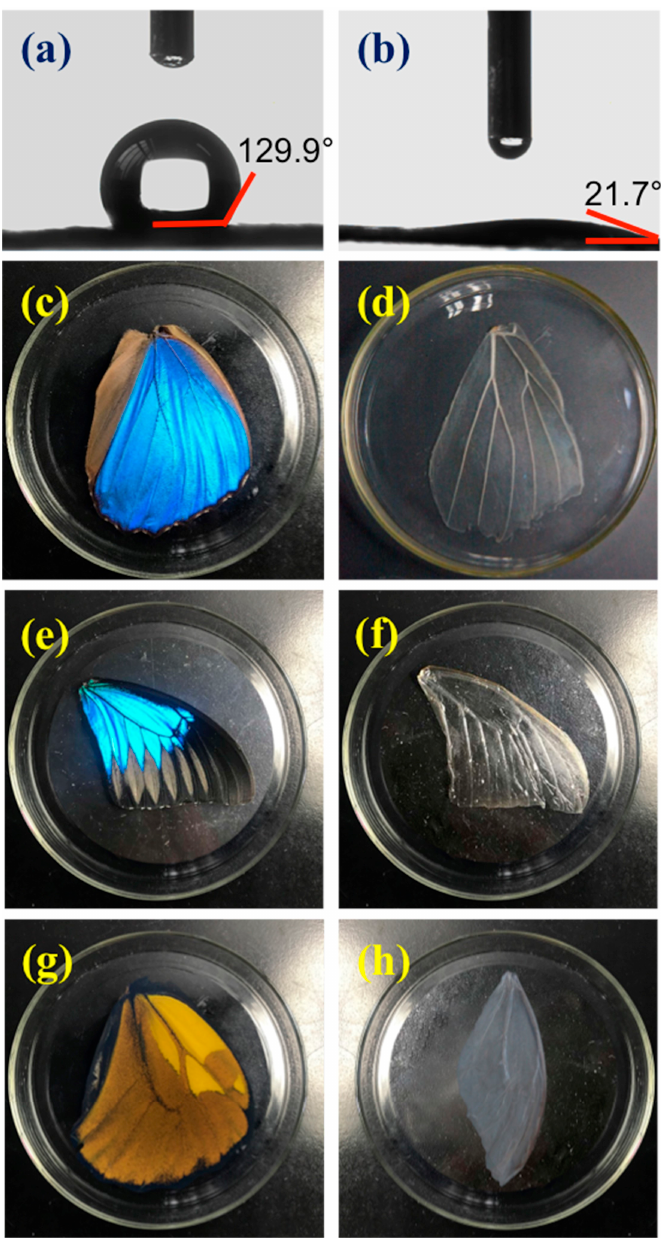
Figure 2. ( a , b ) are the water contact angle of M. menelaus pre and post plasma treatment. ( c , d ) are the optical image of M. menelaus wing pre and post chemical treatment. ( e , f ) are the optical image of P. u. telegonus wing pre and post chemical treatment. ( g , h ) are the optical image of O. c. lydius wing pre and post chemical treatment.